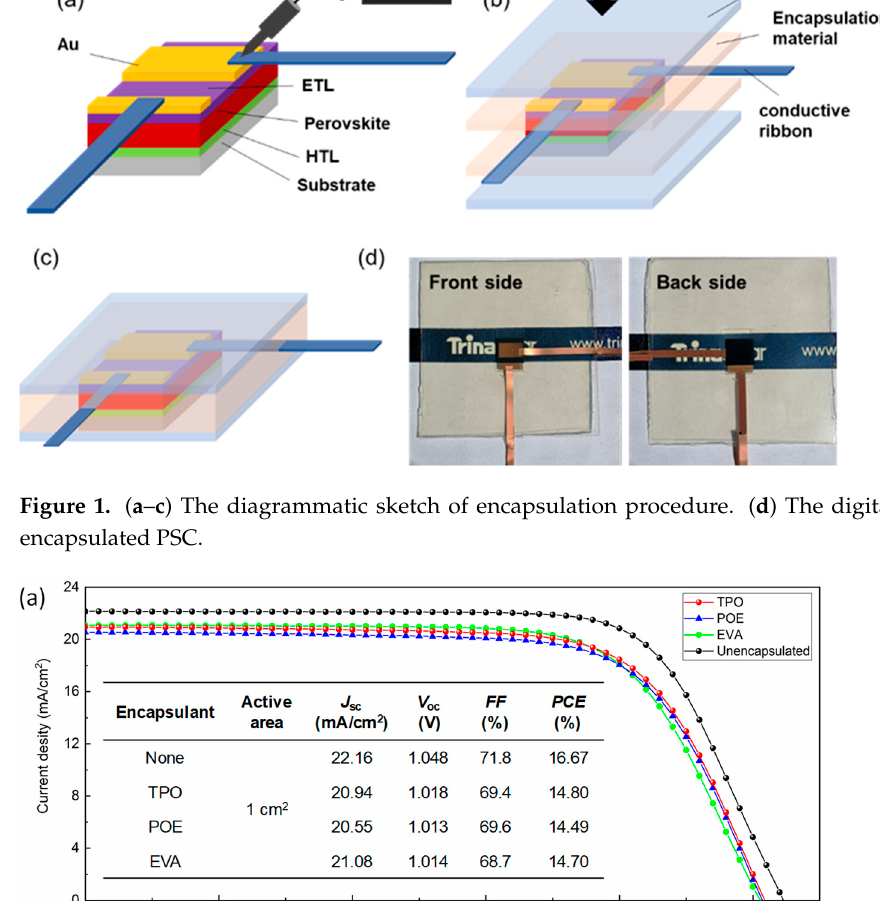
Figure 2. ( a ) J-V curve of the PSCs before and after encapsulation with different materials. ( b ) The transmittance of FTO, backsheet, and backsheet overlay with encapsulant. ( c ) Absorption spectra of bare perovskite film, perovskite films/laminated TPO, and perovskite/laminated TPO/backsheet.